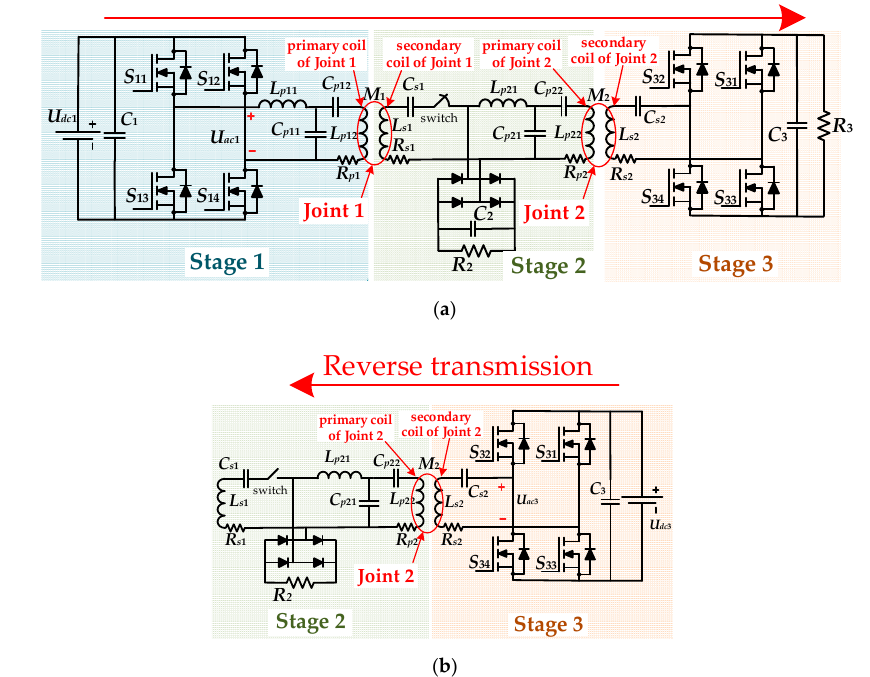
Figure 1. Multi-stage bi-directional wireless power transfer (WPT MB-WPT) system. ( a ) Mode A; ( b ) Mode B.